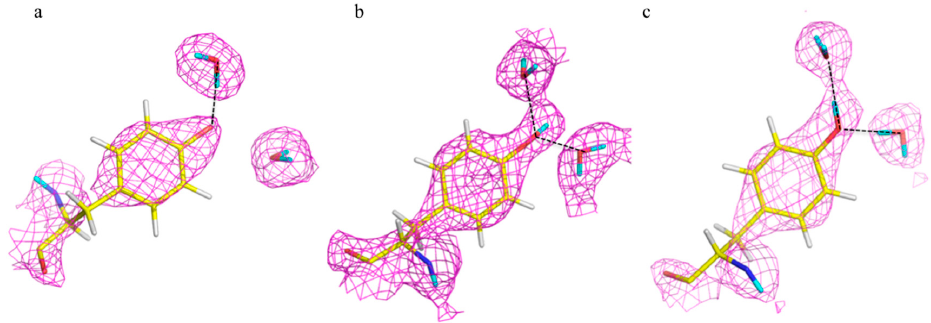
Figure 3. Three different states of Tyr7 in human carbonic anhydrase II. ( a ) Tyr7 is deprotonated at high pH; ( b ) Tyr7 is neutral at neutral pH but involved in a bifurcated H bond; ( c ) at pH 6.0 Tyr7 is still neutral and involved in a conventional H bond, participating as both acceptor and donor. 2F o − F c nuclear density maps are shown in magenta and are contoured at 1.3 σ level. PDB IDs used ( a ) 3kkx, ( b ) 3tmj, and ( c ) 4y0j.